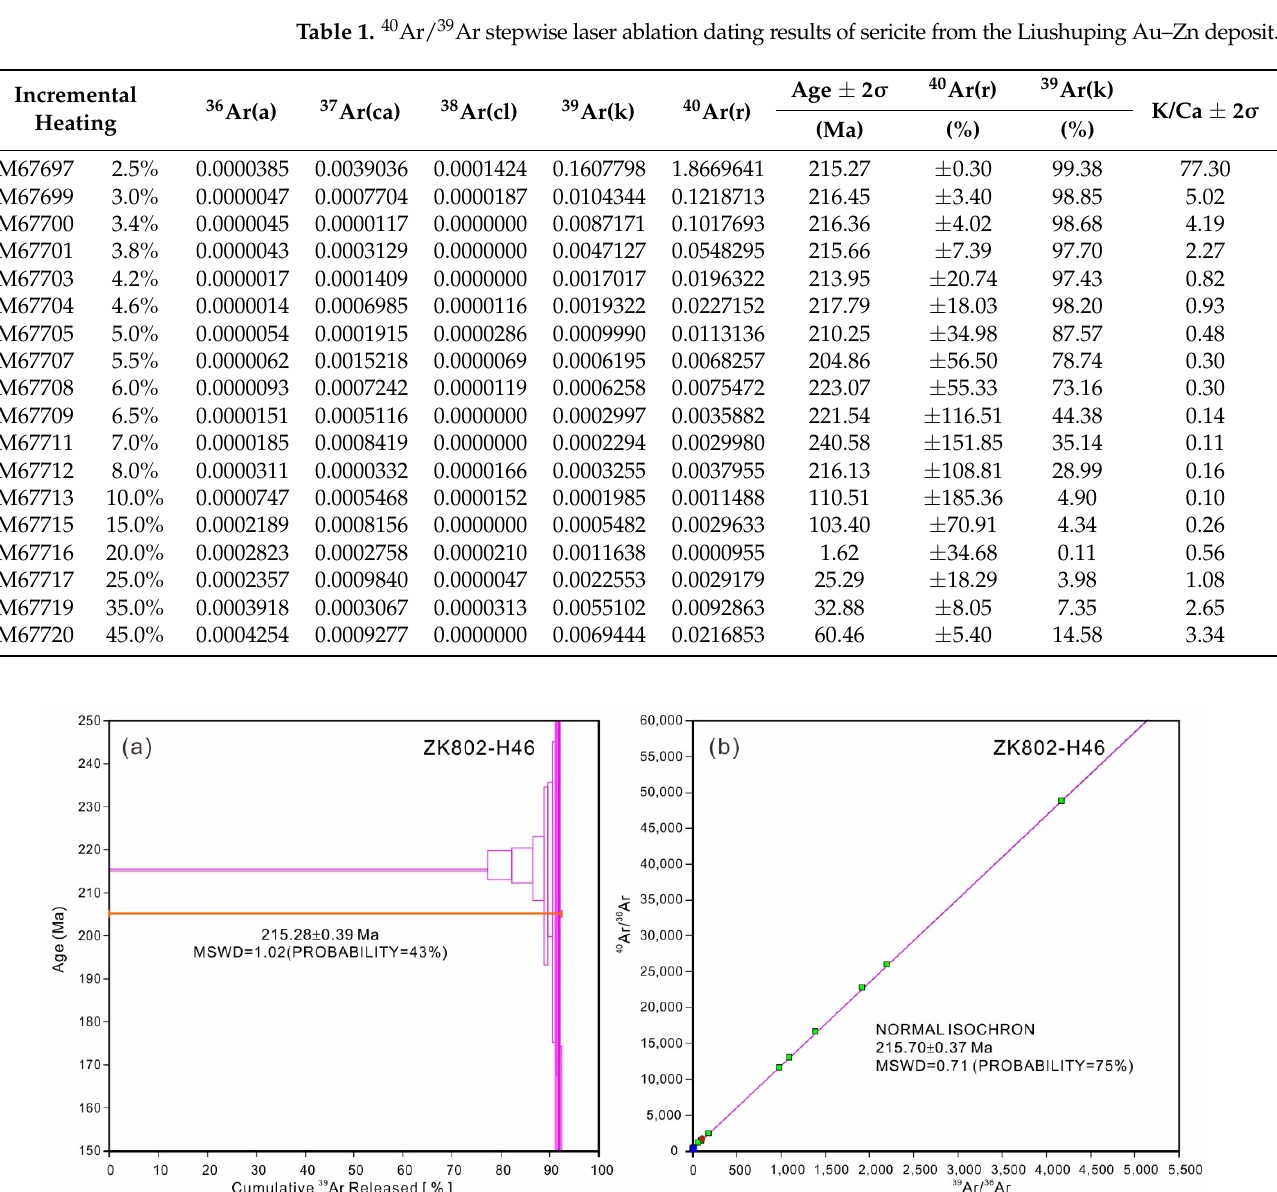
Table 1. 40 Ar/ 39 Ar stepwise laser ablation dating results of sericite from the Liushuping Au–Zn de ‐